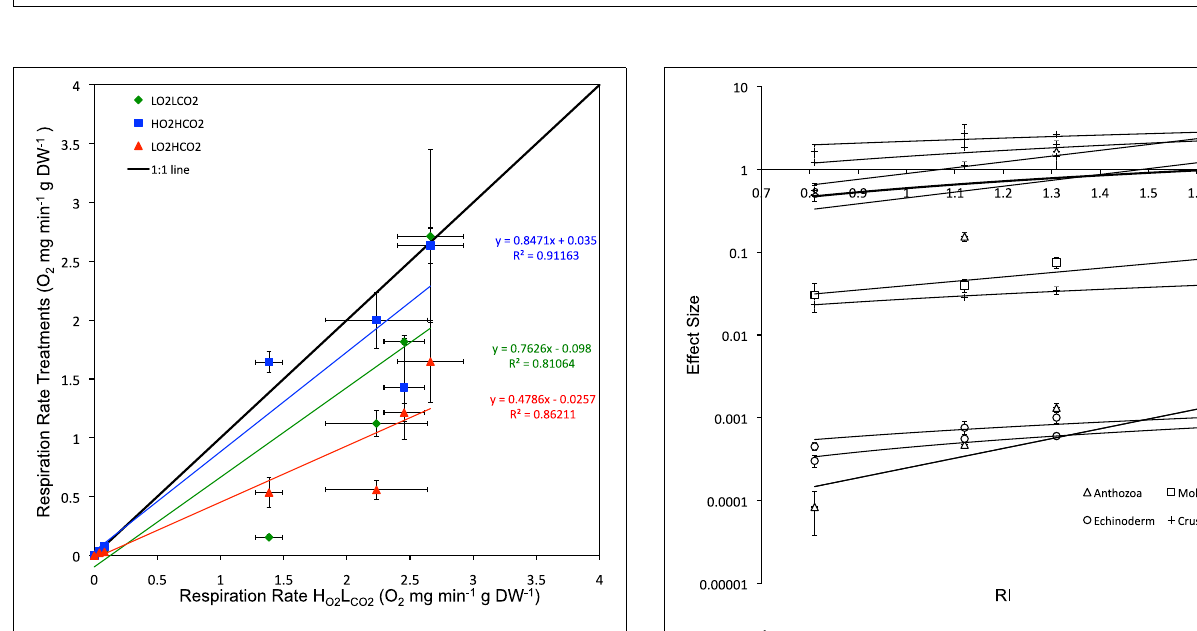
FIGURE 4 | Respiration rate (Average ± SE) after 6 days of all tested species: green – L O2 L CO2 , blue – H O2 H CO2 and red – L O2 H CO2 . differences and in Petrolisthes violaceus a significant antagonistic effect was observed.